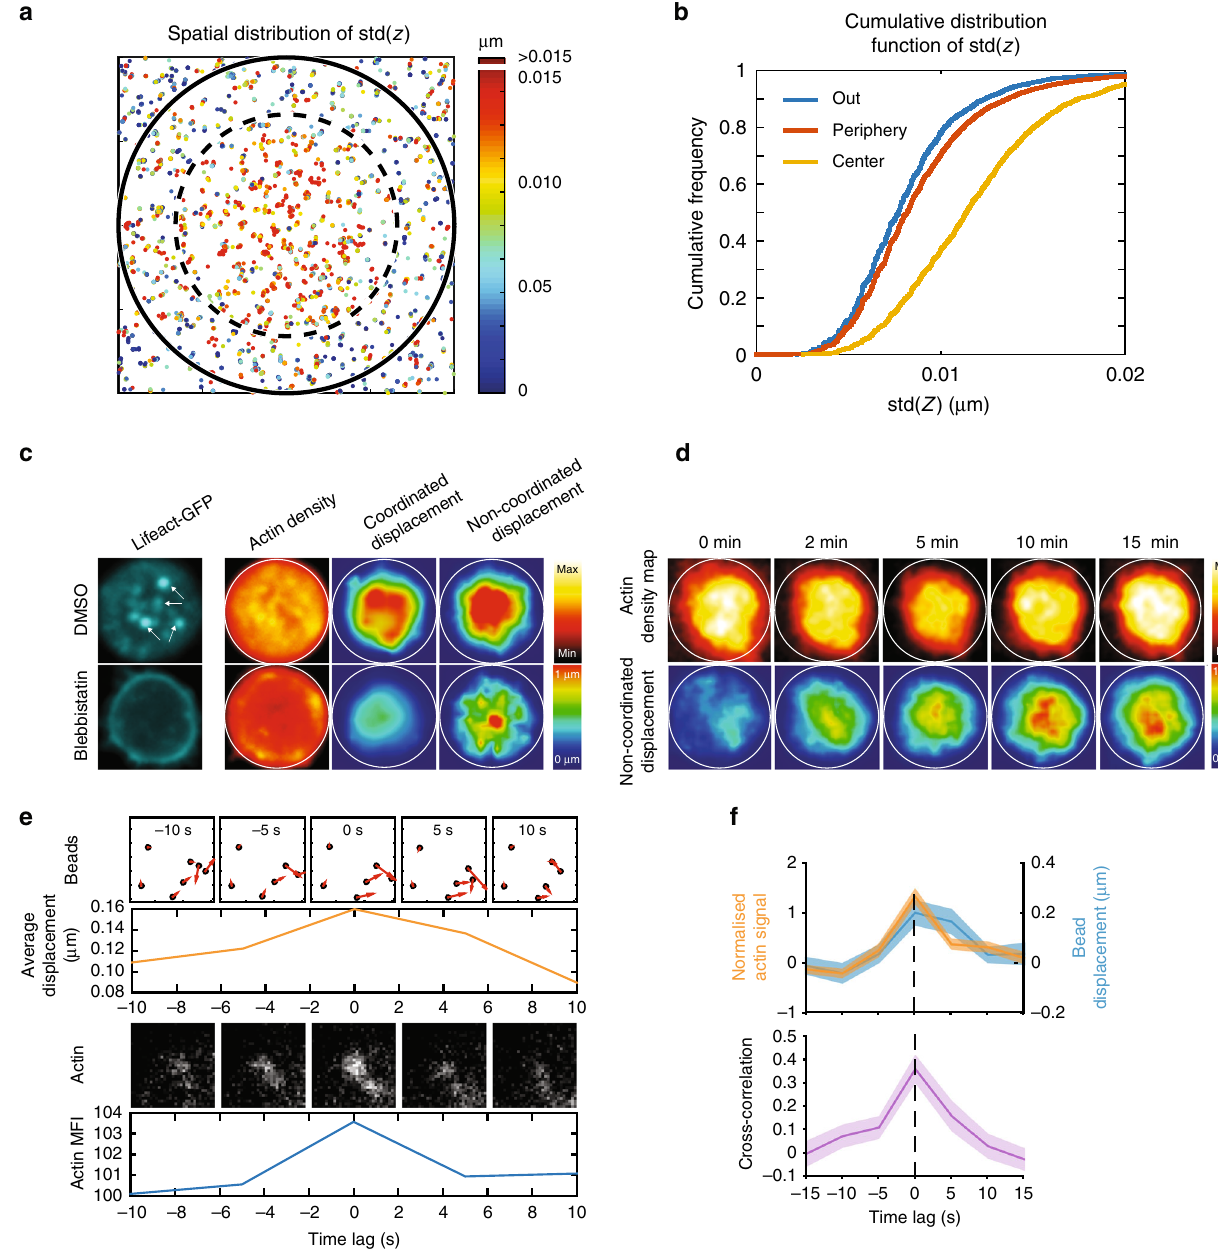
Fig. 5 Actin dynamics at the synapse. a Space distribution of bead displacement in the z direction: each point represents the standard deviation of the z position of a single bead on a 10 frame sequence; all beads have been projected on a size and aspect ratio normalized cell (inner circle at 2/3 of the cell diameter) represents the central portion of the synapse: the fi gure show that the displacement in z is higher in the center of the synapse (8422 points, superposition of 14 cells, one representative experiment). b Cumulative distribution for the z displacement color-coded in fi gure a , the central fraction of beads shows signi fi cantly higher displacement in z ( P < 0.0001 for all comparison, Kolmogorov – Smirnov test). c Left, single cell showing actin patches in the center of the cell which are lost in case of para-Nitroblebbistatin treated cells. Right, mean actin distribution, mean coordinated and mean non- coordinated force density color map in control and para-Nitroblebbistatin treated B cells ( n = 12). d Actin distribution over time correlates with non- coordinated force distribution (images are average projection of 12 cells over all time points). e Time-lapse images showing simultaneous appearance of an actin patch and non-coordinated bead displacements, arrowhead showing direction and magnitude of displacement; graphs below the images represent the respective signals integrated over a square of 2 µ m × 2 µ m. f Average of the signals quanti fi ed in e and average cross-correlation: both signals appear simultaneously and show a peak simultaneously with no lag (mean ± SEM, n = 89, from nine cells, two independent experiments). Source data are provided as a Source Data fi